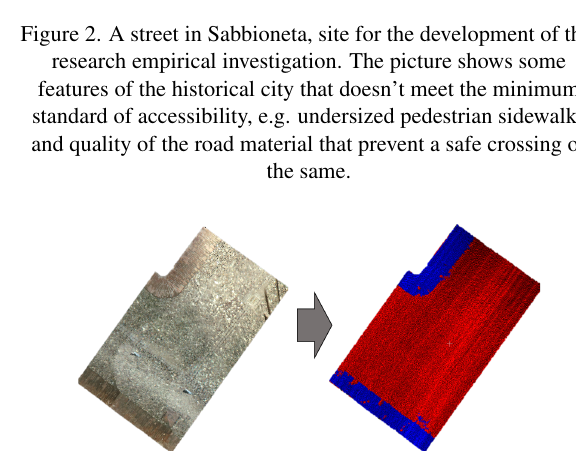
Figure 3. The next step of the project will deal with point cloud segmentation. Here is a first example of portion of road, on left, and its classification in street (red) and sidewalks (blue), on right. with well-defined rules and instead historic centers with